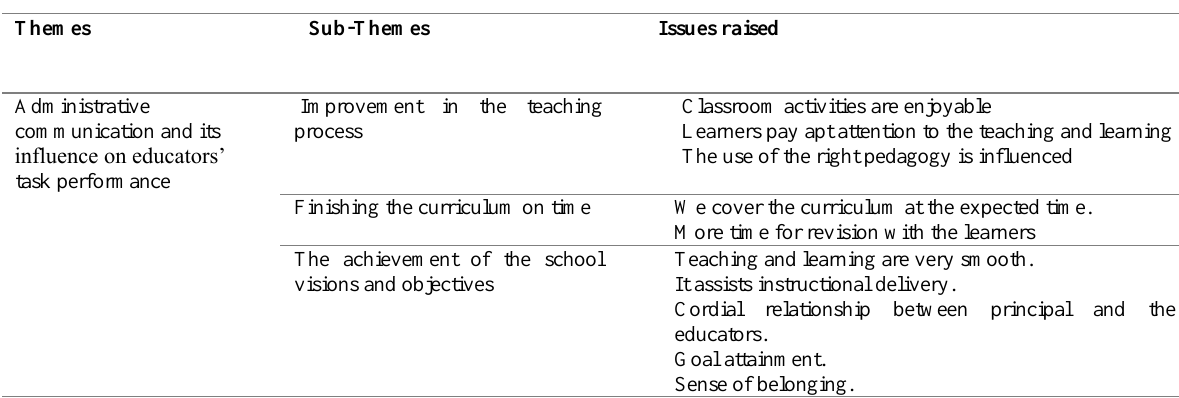
Table 2 : Themes and sub-themes concerning administrative communication and its influence on educators’ task performance